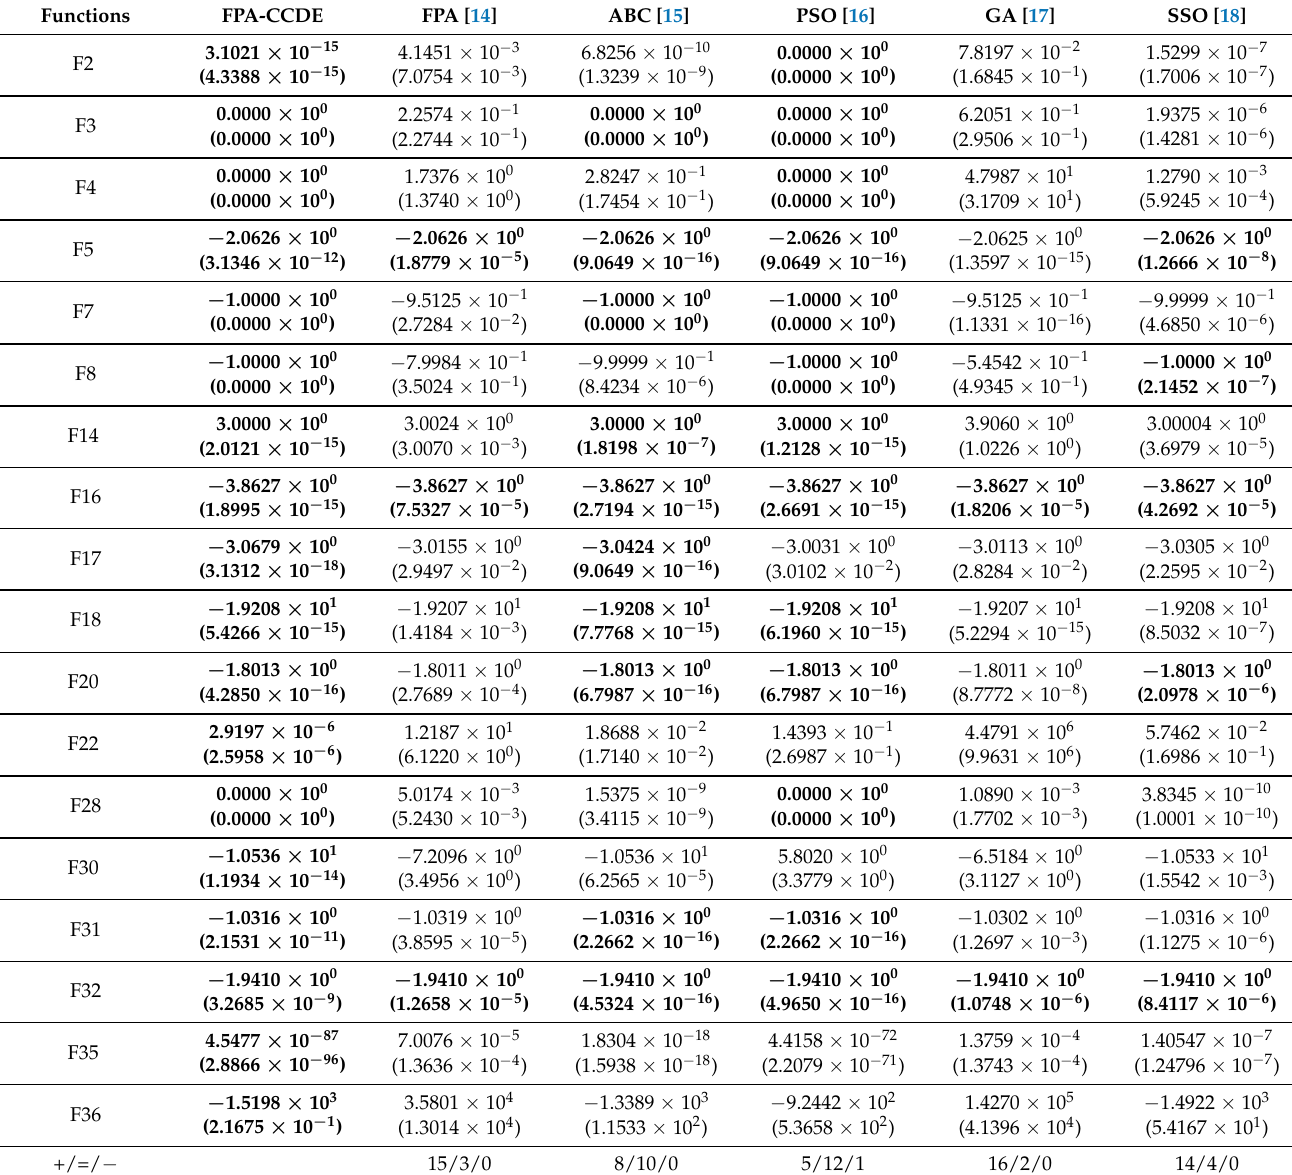
Table 2. Experimental results of benchmark function with low